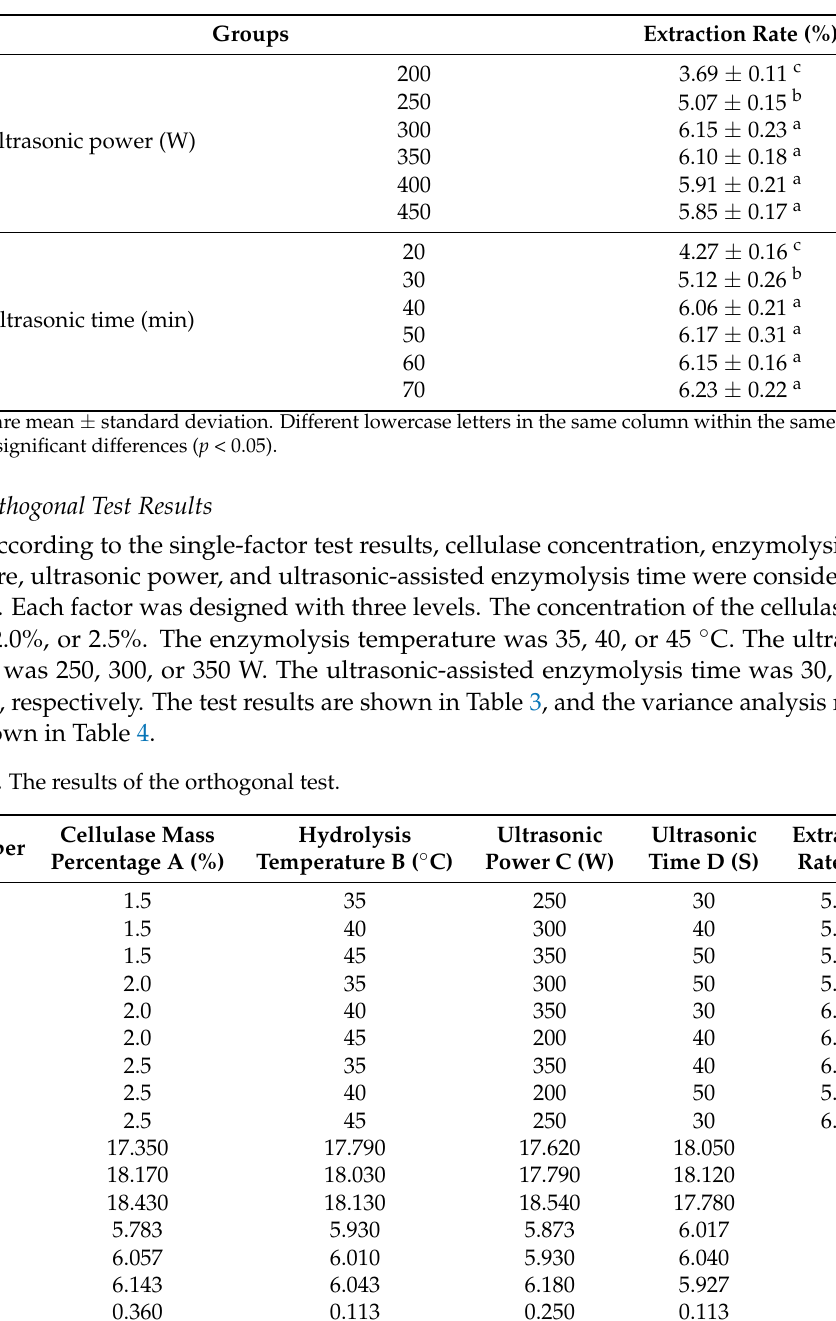
Table 2. Effect of ultrasonic power and time on flavonoids extraction rate.